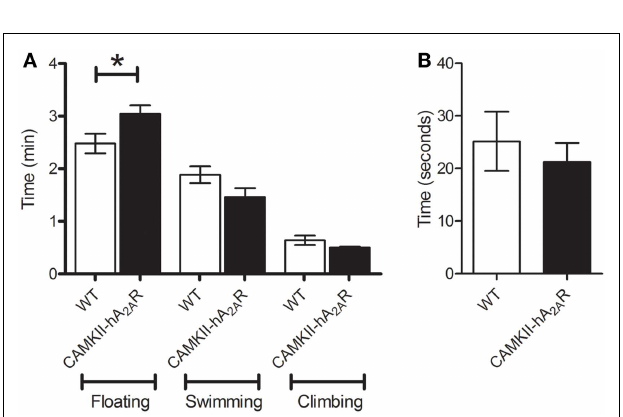
FIGURE 6 | Forced swim test . (A) Time spent floating, swimming, and climbing; (B) latency to the first period of immobility – results are expressed as means ± SEM. p < 0.05WT: n = 12;Tg(CaMKII-hA2AR): n =